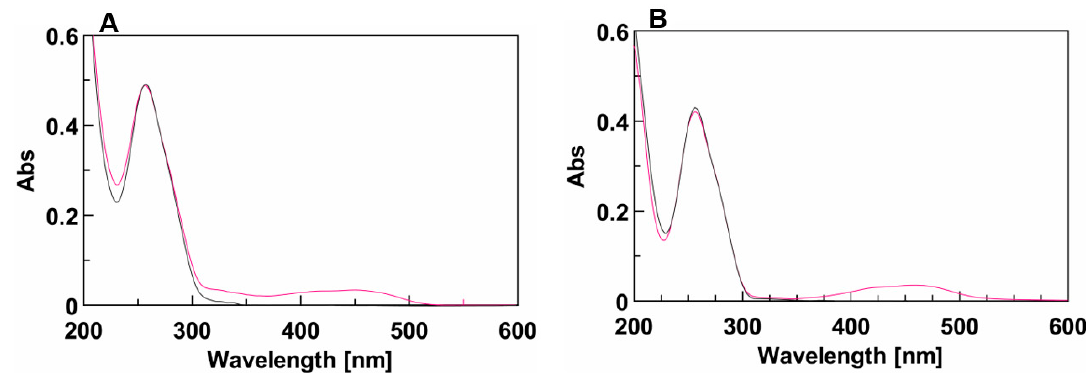
Figure 2. ( A ) UV spectra of TBA (black line) and 5 (cid:48) -DMAzo-TBA (fuchsia line) in 100 K bu ff er (pH = 7.4) in the range 200–600 nm. ( B ) UV spectra of T30695 (black line) and 5 (cid:48) -DMAzo-T30695 (fuchsia line) in 10 K bu ff er (pH = 7.4), in the range 200–600 nm. The spectra were acquired at 10 ◦ C using [ON] = 20 µ M. cuvette o.l. 0.1 cm, V = 400 µ